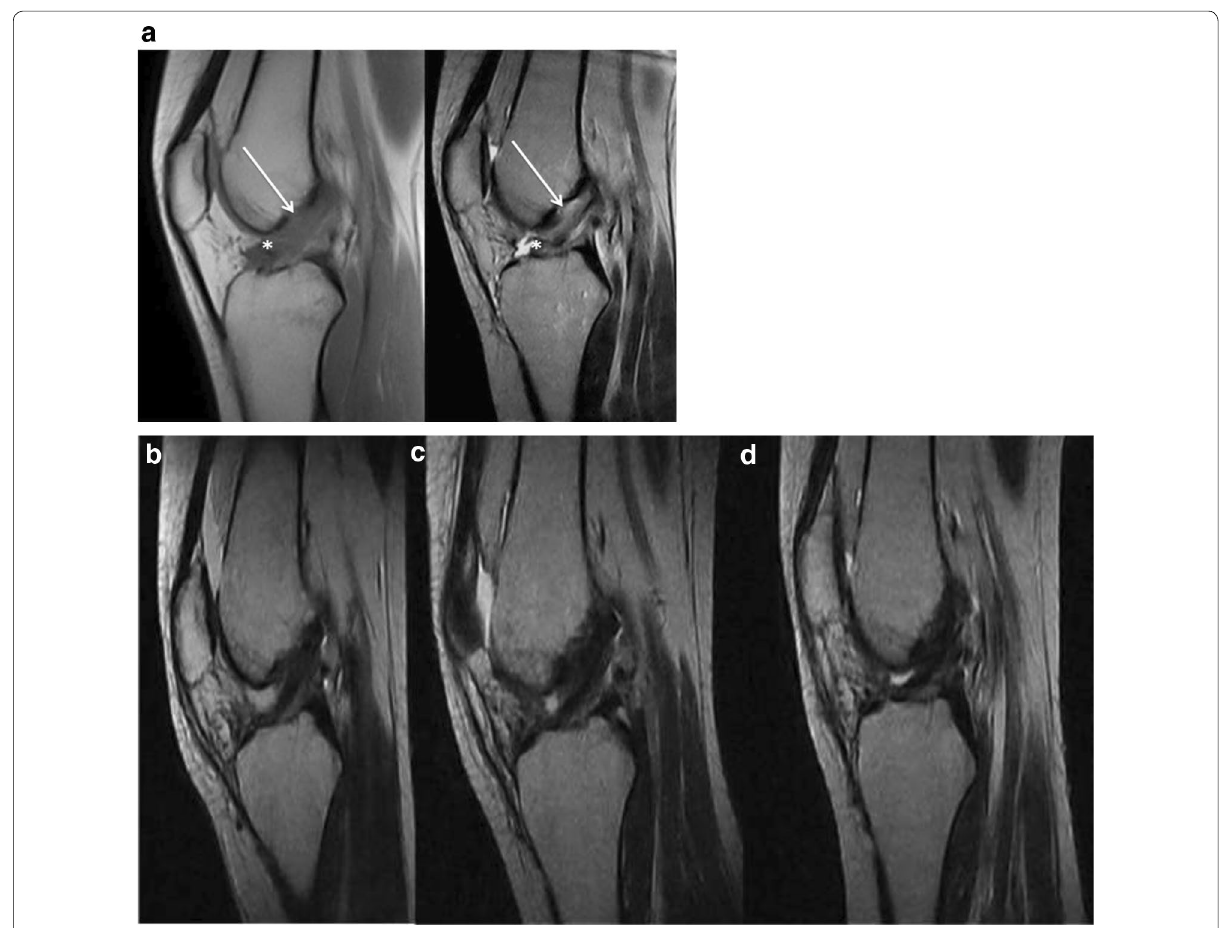
Fig. 3 Pre- and postoperative images of patient #3. a Sagittal preoperative MRI T1-TSE (left) and T2-TSE (right). Tear location (arrow): type III; tissue quality (asterisk): good b Sagittal T2-TSE 1 month post-op. Morphology: grade 1 (normal); signal intensity: grade 1 (isointense) c Sagittal T2-TSE 3 months post-op. Morphology: grade 1 (normal); signal intensity: grade 1 (isointense) d Sagittal T2-TSE 6 months post-op. Morphology: grade